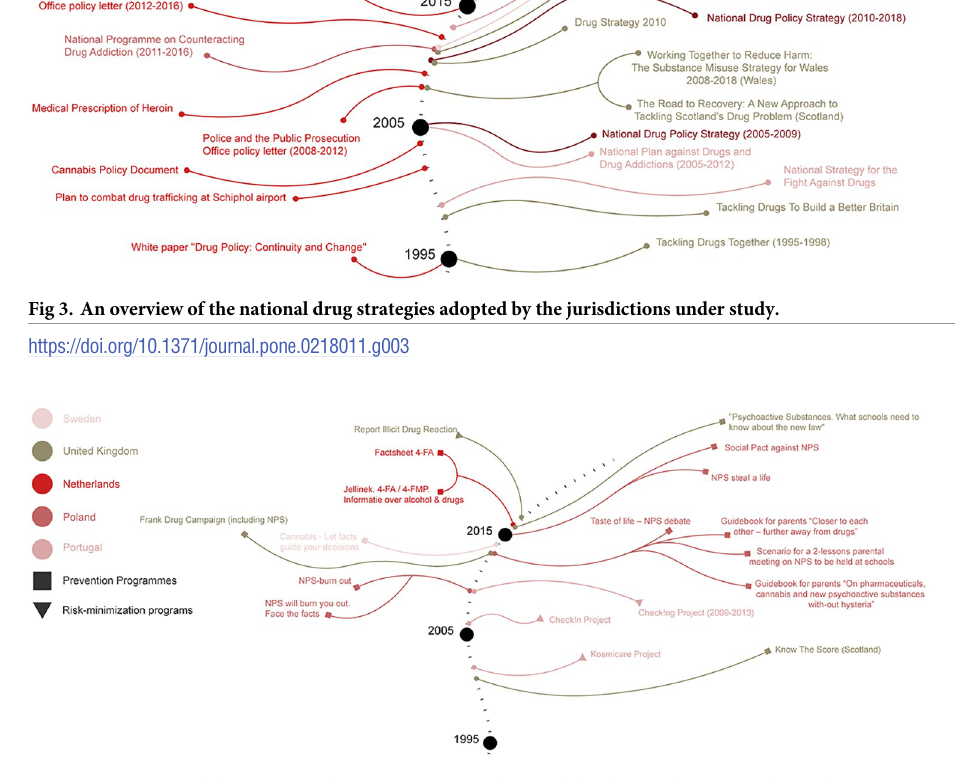
Fig 4. An overview of the NPS-specific programmes implemented by the jurisdictions under study.